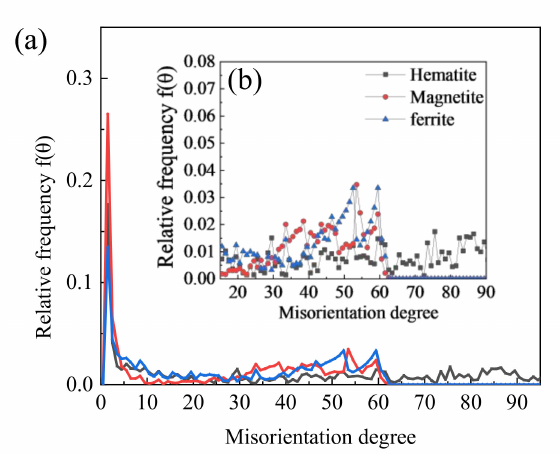
Figure 7. Distribution map of grain boundary misorientation of different phases in the oxide scale, the sample with the reduction rate of 15% and cooling rate of 18 ◦ C/s, ( a ) all boundaries. ( b ) high angle grain boundaries with misorientation >15 ◦